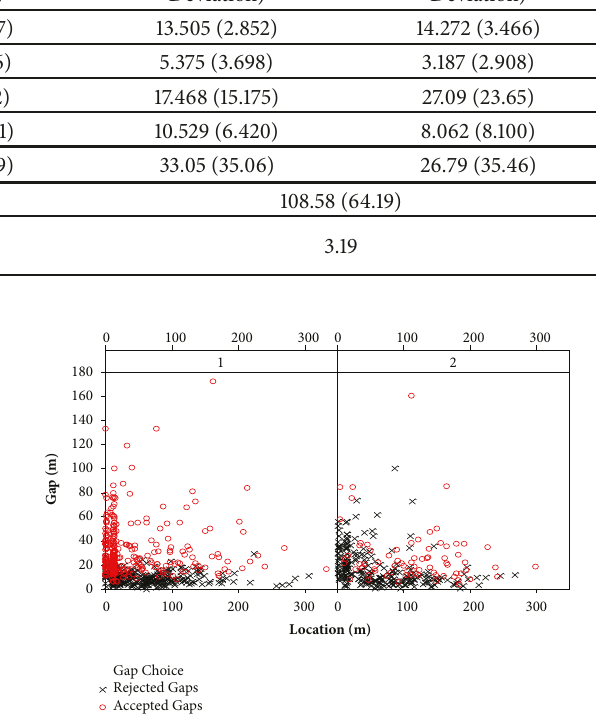
Figure 2: Relation between the gap size and location for therejected and accepted